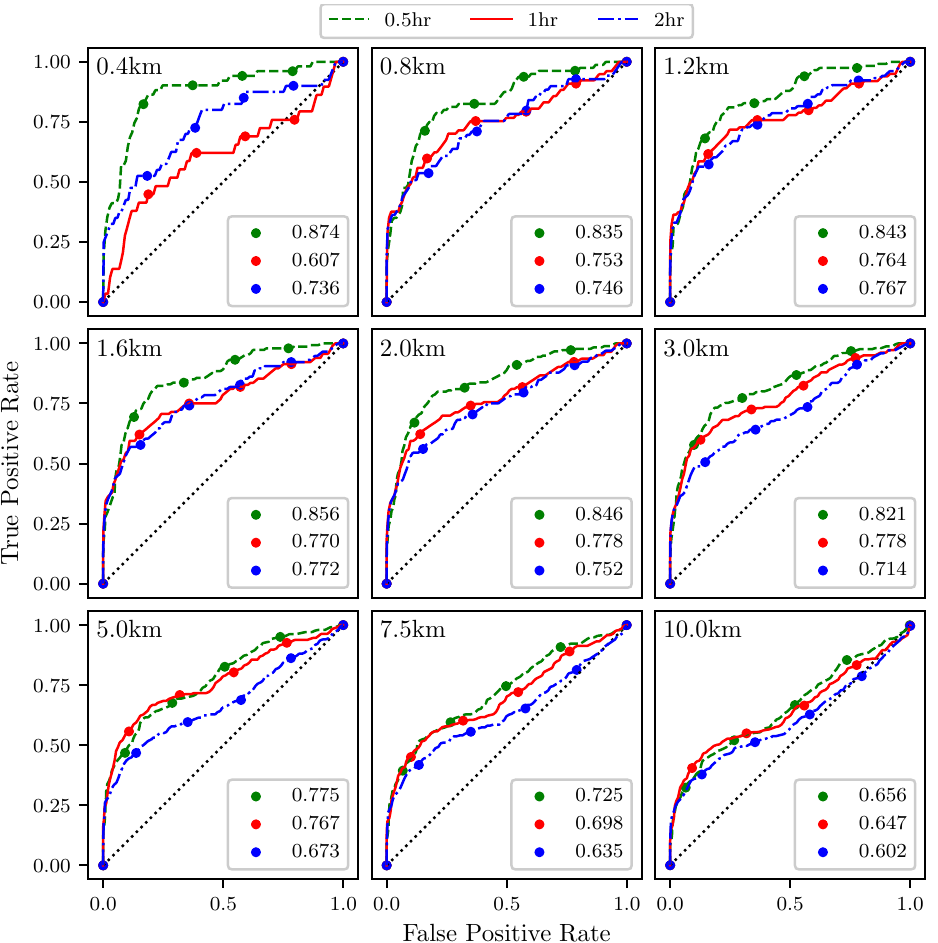
Figure 16. ROC curves for the attraction rate, s 1 , as measured from a 2 km radius UAS simulation ability to detect 90th percentile LCSs with integration times of 0.5 ( green ), 1 ( red ), and 2 ( blue ) h. The threshold radius for each subplot is displayed in the upper left hand corner. The AUC for each integration time is given in the